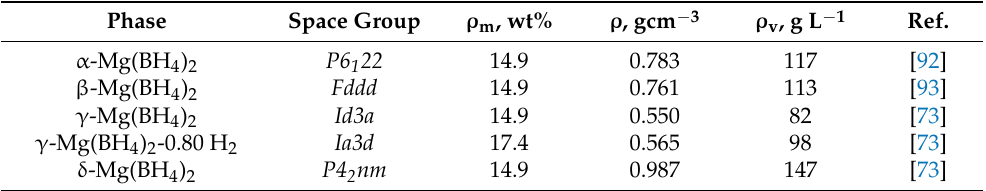
Table 2. Experimental gravimetric ( ρ m ), specific ( ρ ) and volumetric ( ρ v ) densities of different Mg(BH 4 ) 2